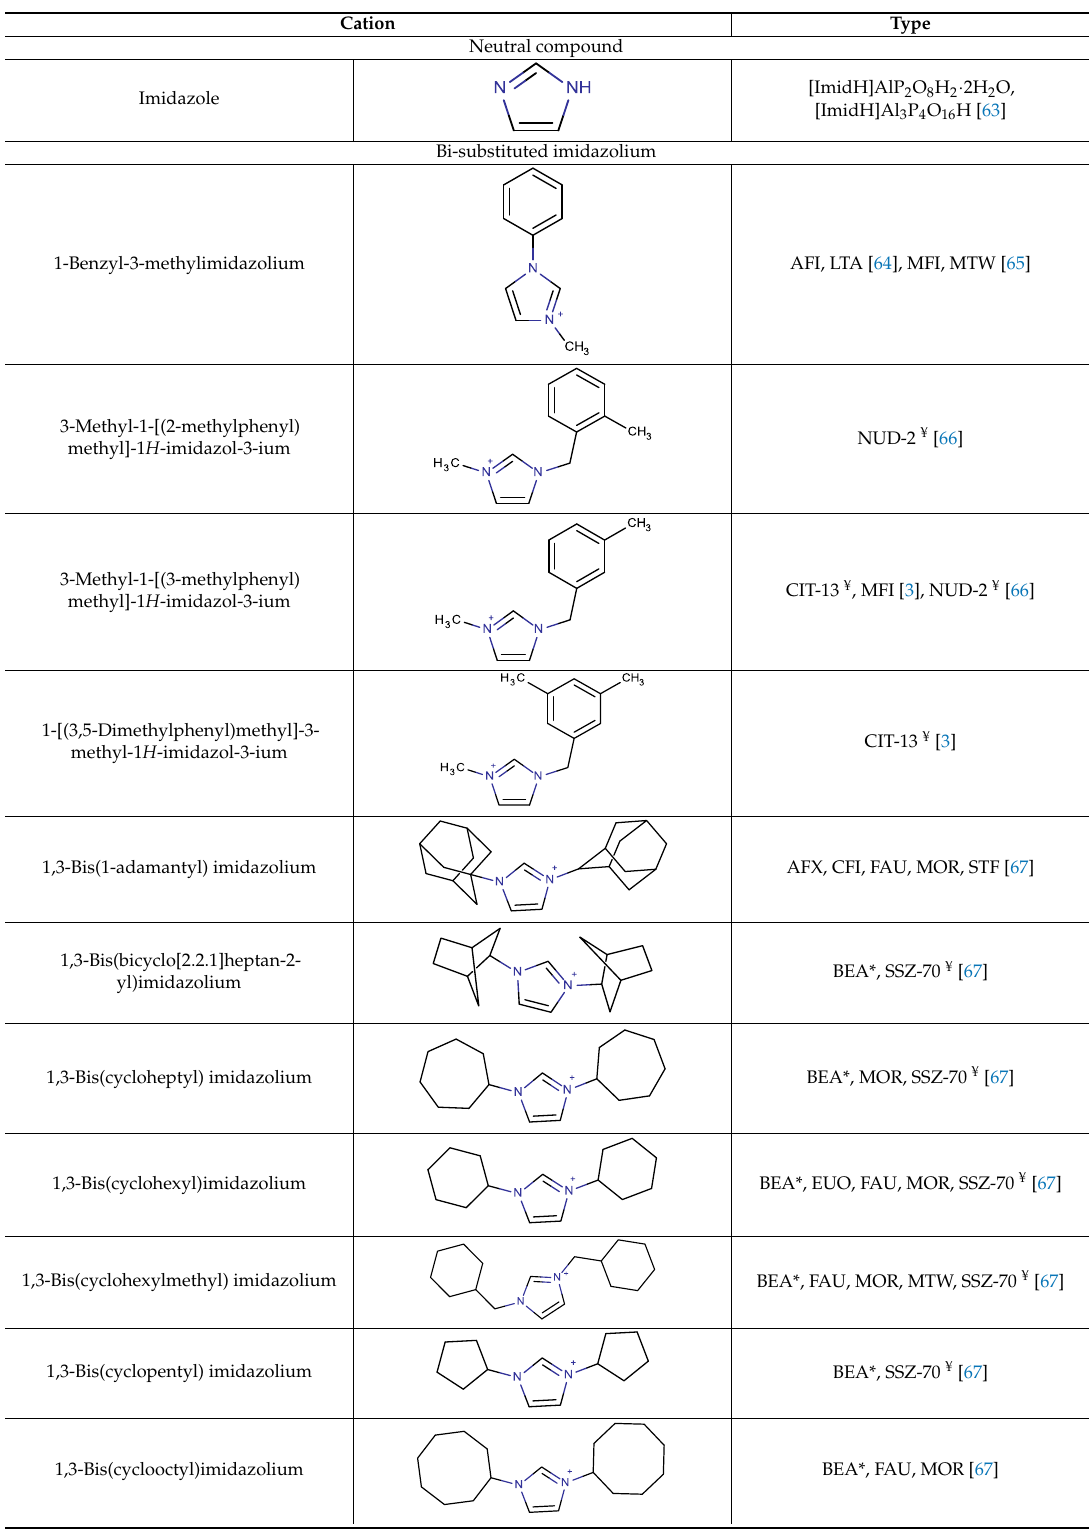
Table 3. Imidazolium-based cations used in zeolite and zeotype syntheses (the cations were designed with the program Marvin Sketch [50]).